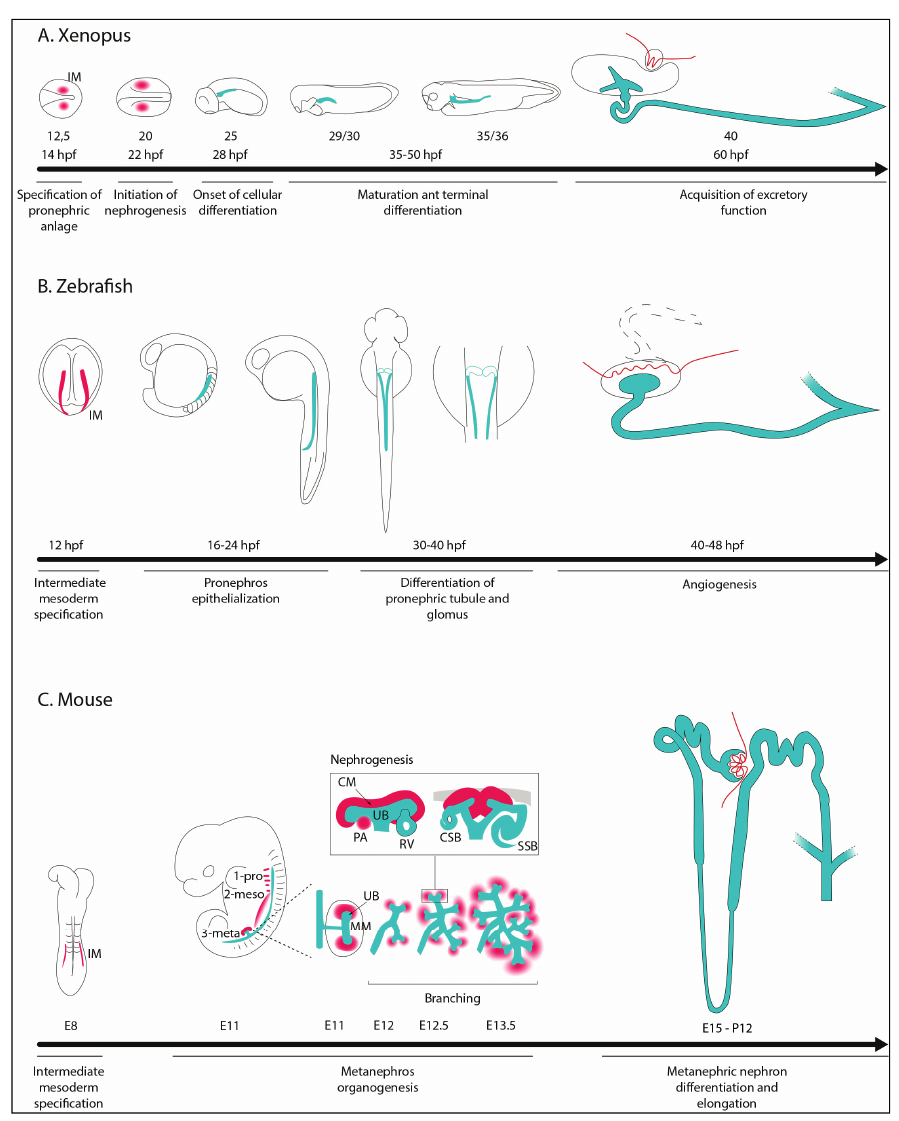
Figure 1. Stages of kidney morphogenesis in Xenopus ( A ); zebrafish ( B ), and mouse ( C ). hpf: hours post-fertilization; IM: Intermediate Mesoderm; pro-: pronephros; meso-: mesonephros; meta-: metanephros; UB: Ureteric Bud; MM: Metanephric Mesenchyme; CM: Cap Mesenchyme; PA: Pretubular Agregate; RV: Renal Vesicle; CSB: Comma-Shaped-Body; SSB: S-Shaped-Body. IM, CM, and PA are shown in red, while renal epithelial tubular structures are in light